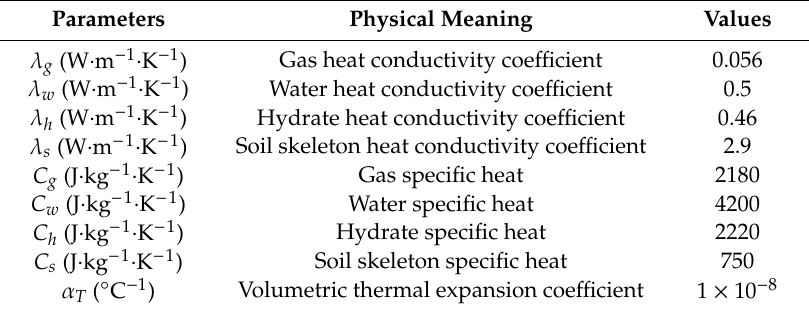
Table 3. Thermodynamic parameters of hydrate-bearing sediments.